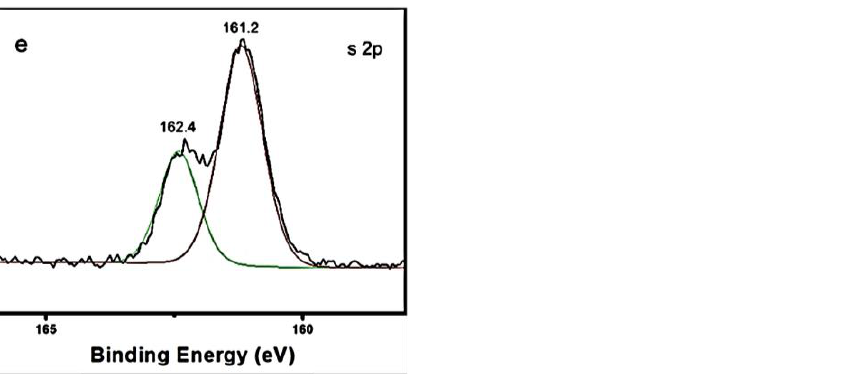
Figure 2. ( a ) Survey XPS spectrum of the CdS-TiO 2 NTs and high-resolution spectra for ( b ) Ti 2p, ( c ) O 1s, ( d ) Cd 3d, and ( e ) S 2p.